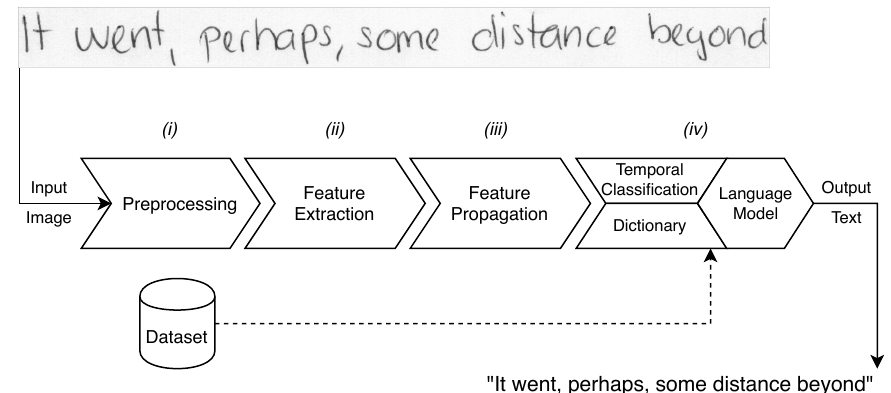
Figure 1. Workflow of the offline handwritten text recognition